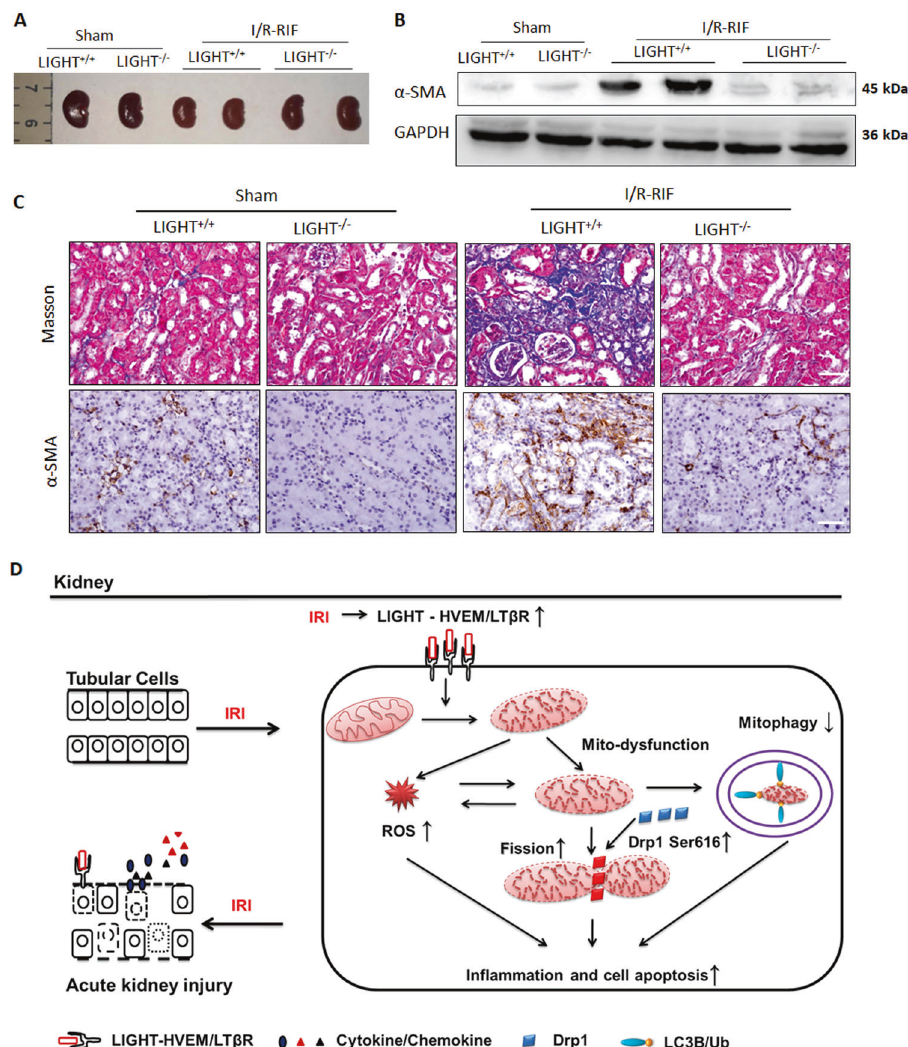
Fig. 9 LIGHT de fi ciency attenuates I/R-induced renal interstitial fi brosis. LIGHT + / + and LIGHT − / − mice received 40 min of renal ischemia (clapping left renal pedicles) and the kidney was collected on day 28. A Gross-morphological changes of kidneys. B Immunoblot analysis of α - SMA in the renal tissue. C Masson and IHC staining ( α -SMA) for renal fi brosis. Scale bar, 50 μ m. D Schematic description of how the LIGHT- HVEM/ LT β R pathway mediates I/R-AKI by promoting oxidative stress and mitochondrial